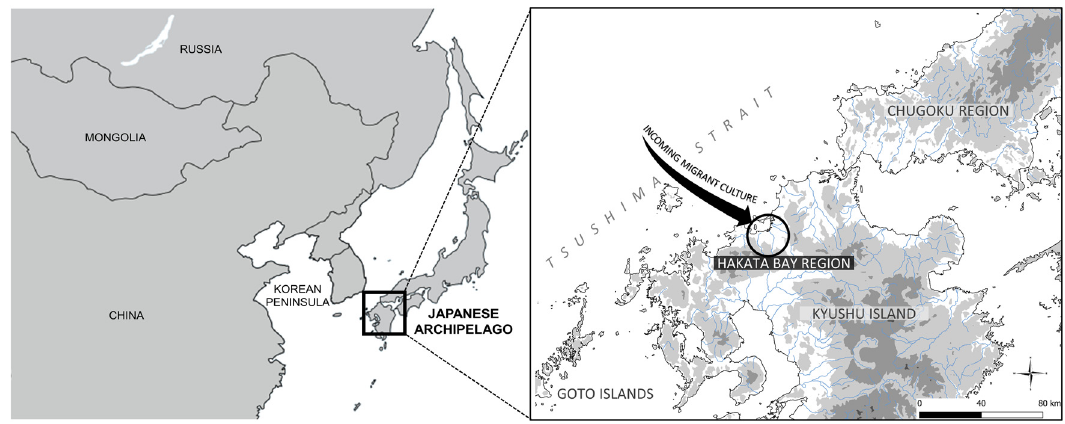
Figure 3: Left: map illustrating the research area within greater East Asia. Right: the greater Kyushu island region and chosen region of study, the Hakata Bay